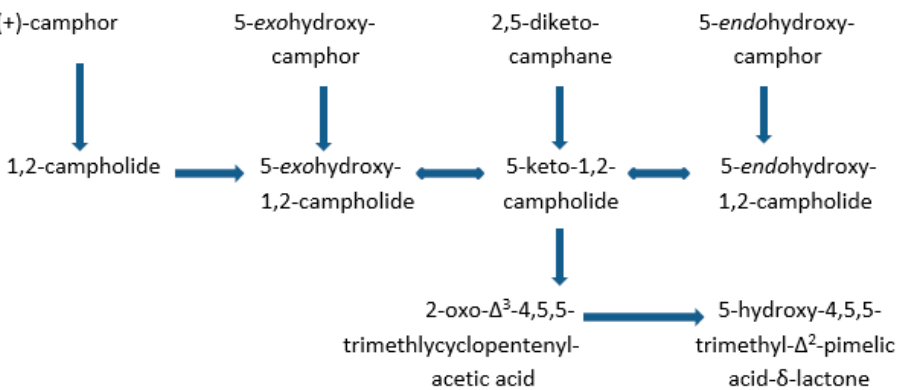
Figure 4. Speculative ‘metabolic grid’ proposed for the early metabolism of (+)-camphor [24,25,27] based on the characterised lactonizing reactions catalysed by partially purified E 2 (2,5-diketocamphane